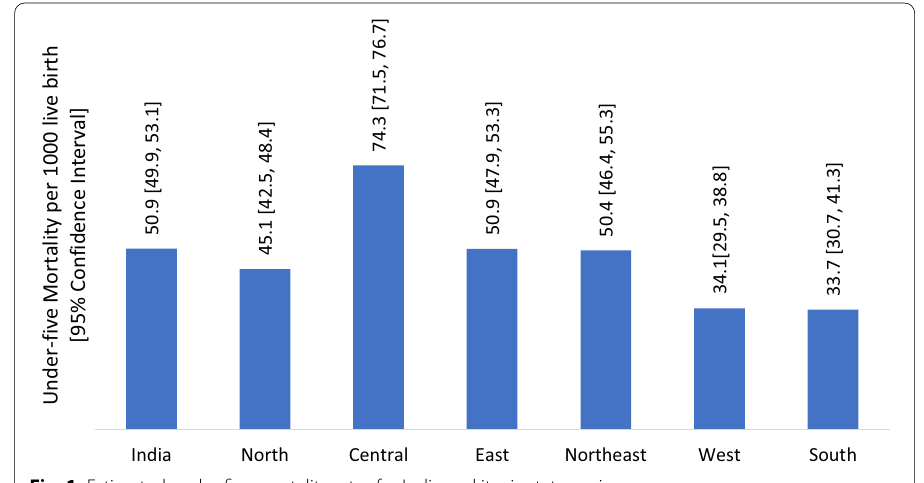
Fig. 1 Estimated under-five mortality rates for India and its six